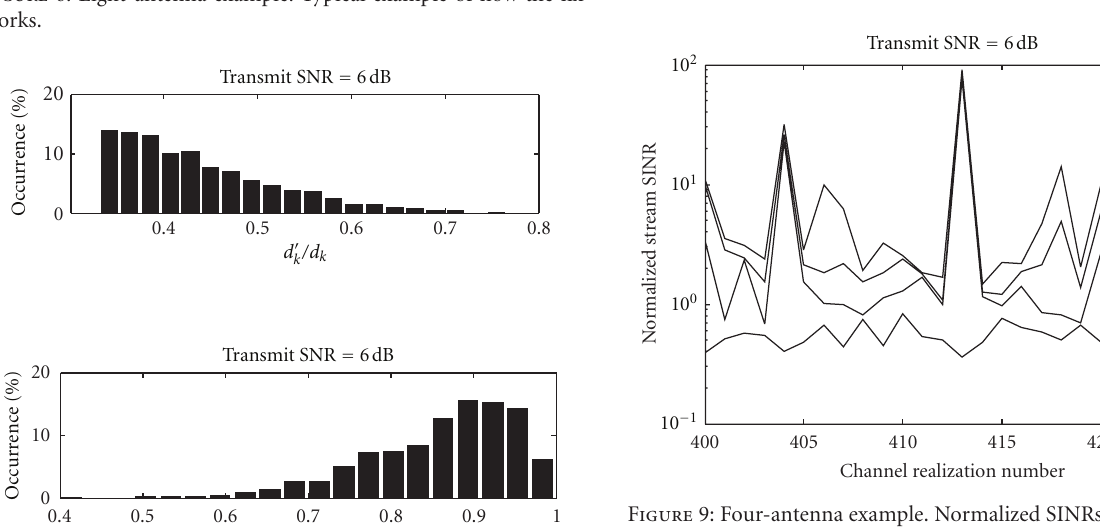
Figure 9: Four-antenna example. Normalized SINRs for the 4 data streams for some channel realizations when the proposed algorithm is employed. The normalization factor is ρ , the SINR of every data stream when the optimum solution is